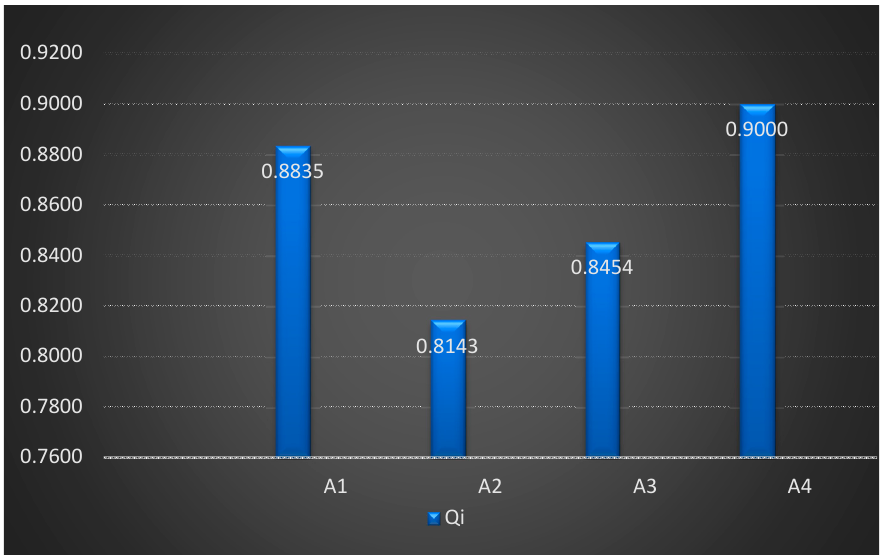
Figure 6. Final ranking without the political criterion.